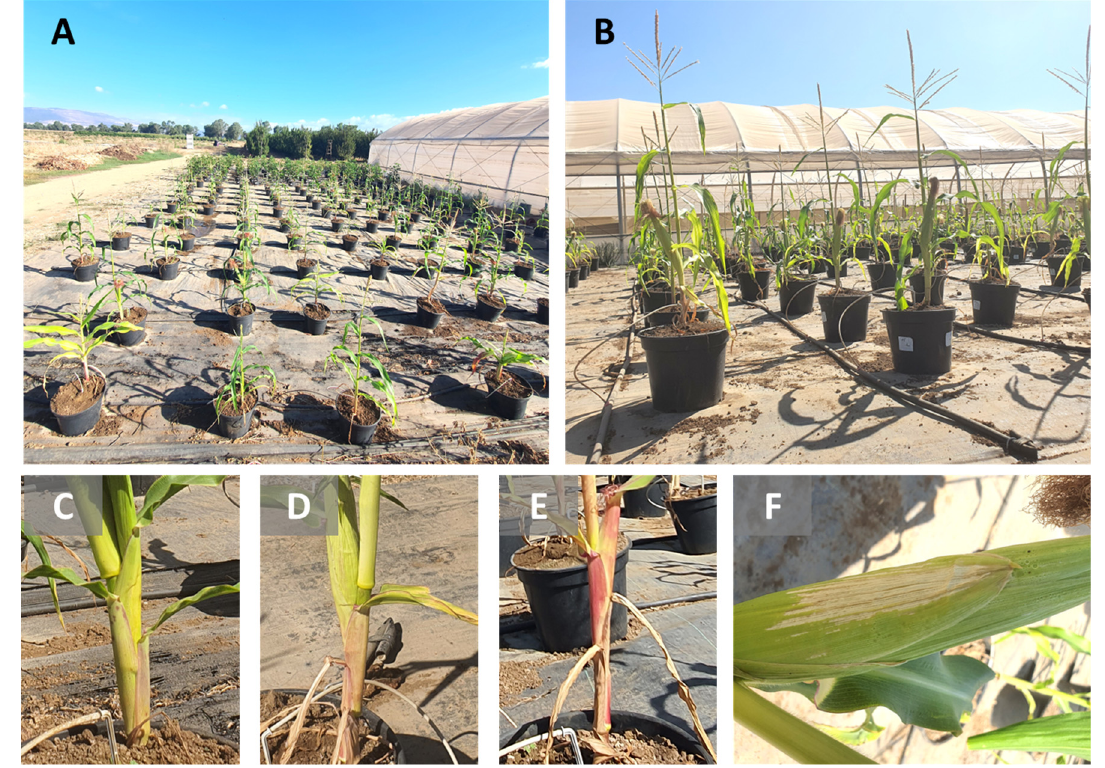
Figure 6. The open-enclosure full-season pots trial design and disease outbreak at harvest (78 days from sowing, 28 days from fertilization). This trial was carried out at the North R&D plantation farm (Hula Valley, Upper Galilee, northern Israel) with the Prelude cultivar (a late wilt disease susceptible sweet maize). The four Trichoderma species (Table 1), alone or combined with chemical protection, were tested against control plants (without biological and/or chemical treatments) in M. maydis -enriched soil. Azoxystrobin (5 mL of the Amistar S.C. preparation, which includes 1.25 mg of the active ingredient per pot) was applied at three intervals from the seeding: after 15, 30 and 44 days. A photo of the full-season trial is presented in ( A ). In the biological treatments, the plants developed well and reached fully matured cobs ( B ), whereas many of the unprotected control plants were diseased and grew poorly. In addition to the vitality of the overall plants and the dry leaves, the disease symptoms can be seen in the lower part of the stalk (( C – E ), with increased severity) and the cobs’ spathes (the large bracts surrounding the cobs, ( F